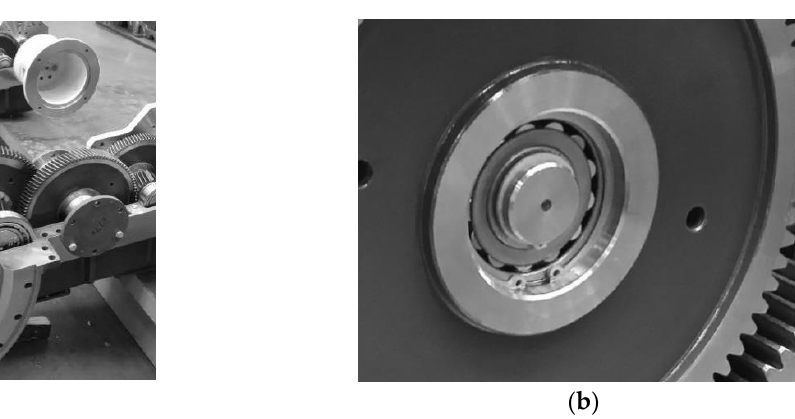
Figure 5. Lifting mechanism of port crane.